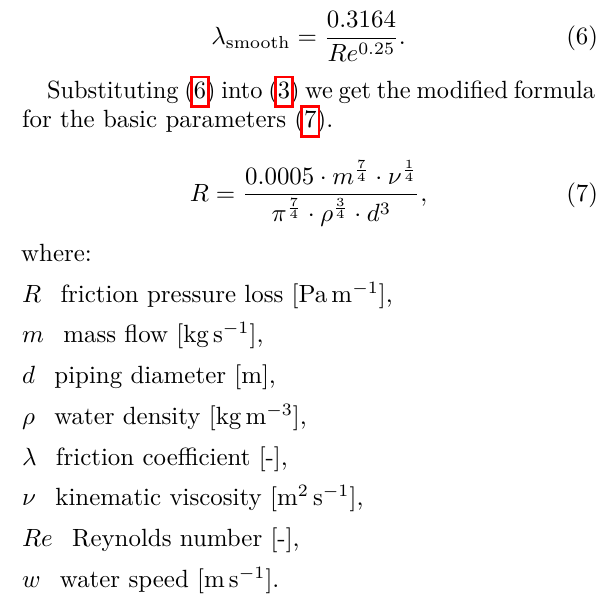
Table 2. Comparison of kinematic viscosity ν and water density ρ as a function of mean water temperature T pressure loss according to the Darcy-Weisbach Equa- tion (3)